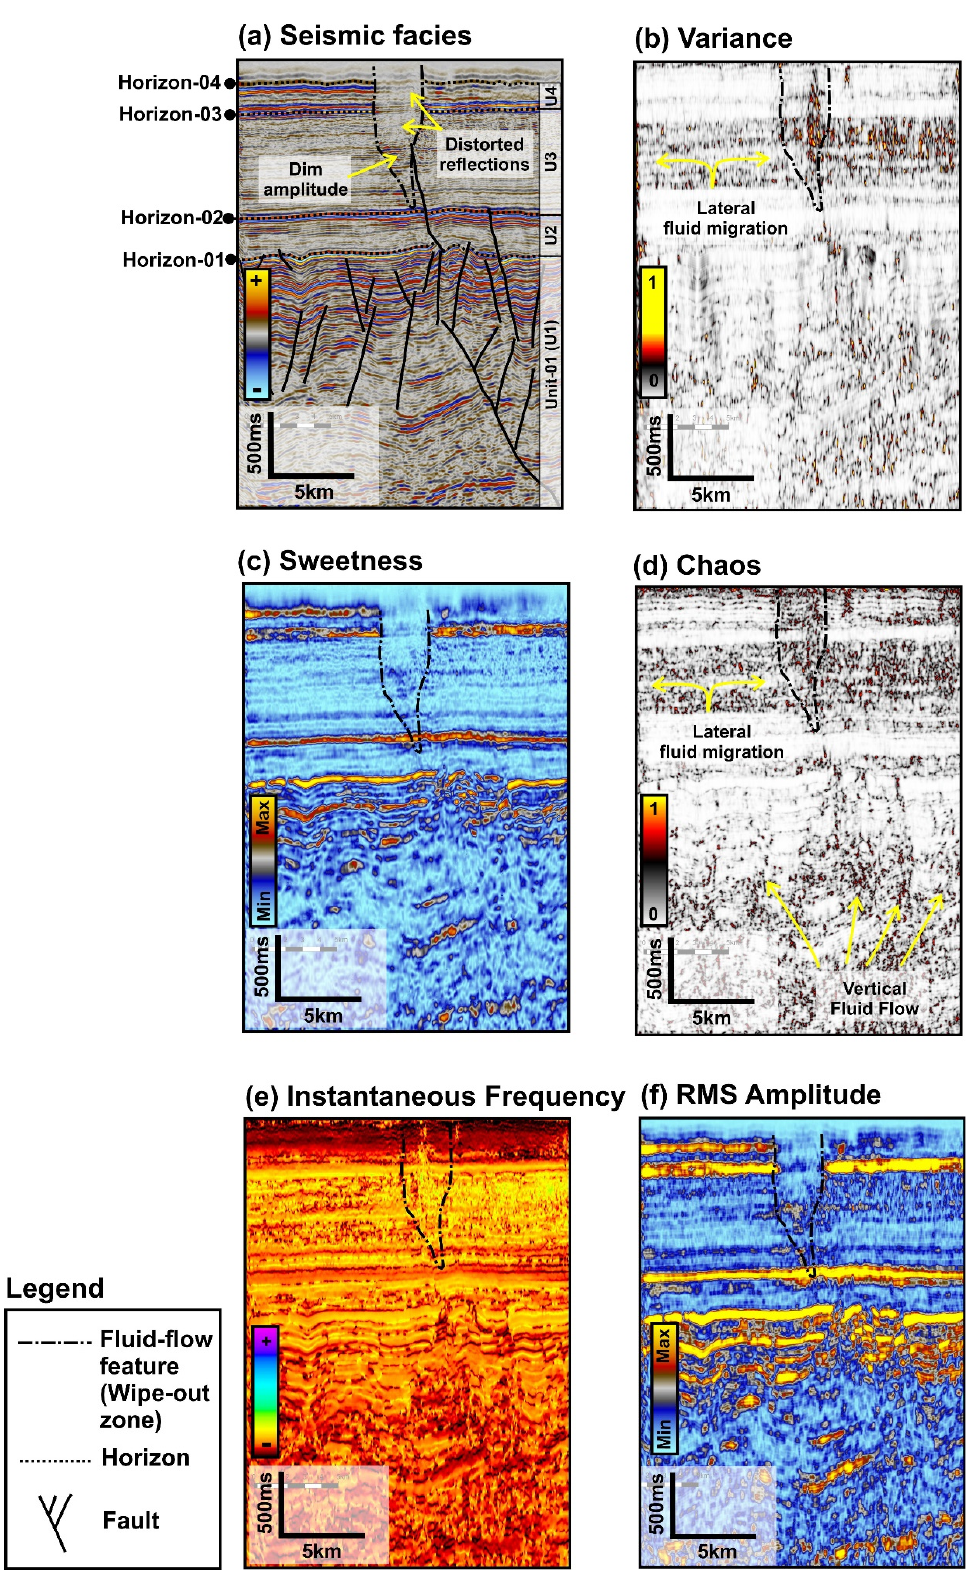
Figure 2. ( a ) Seismic facies and seismic attributes of line 1; ( b ) variance, ( c ) sweetness, ( d ) chaos, ( e ) instantaneous frequency, and ( f ) RMS amplitude, with fluid flow feature interpretation. See Figure 1a for section